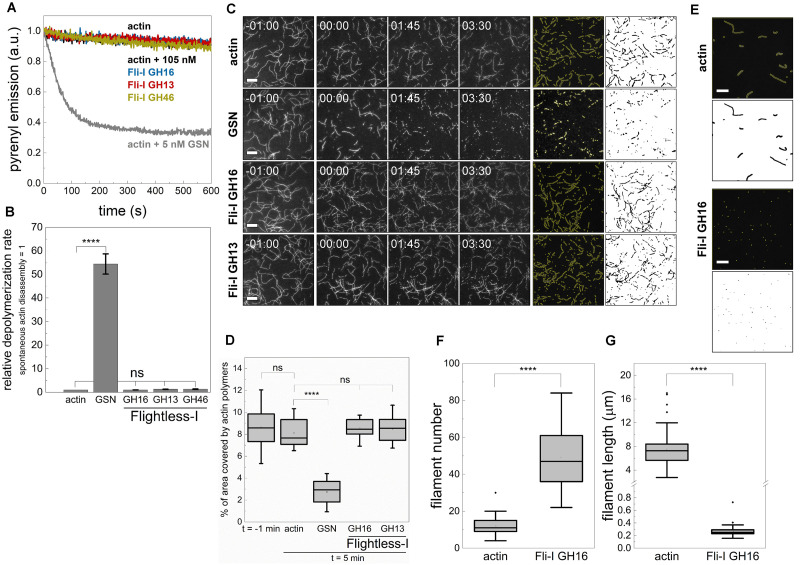
The gelsolin homology domains of Flightless-I do not sever filaments but facilitate the formation of nucleation intermediates. (A) Kinetics of actin polymer disassembly as followed by the decrease in pyrenyl fluorescence emission in the absence or presence of GST-Fli-I or GSN. Conditions: [actin] = 50 nM (50% pyrenyl labeled), [GSN] = 5 nM, [GST-Fli-I] = 105 nM, [CaCl2] = 1 mM. Note that the depolymerization of F-actin in the absence (actin; black line) and presence of different GST-Fli-I constructs (105 nM; blue, red and yellow traces, as indicated) follow similar kinetics; the pyrenyl traces largely overlap. While that of recorded in the presence of GSN (5 nM; gray) differs significantly. (B) Relative depolymerization rate derived from the pyrenyl transients shown on panel (A), n = 2–3. (C) Left panels: Representative montages of actin disassembly followed by TIRFM in the absence or presence of GST-Fli-I or GSN. The frames labeled by -01:00 and 00:00 show the field of view just before and right after the addition of GSN or GST-Fli-I, respectively. Right panels: Representative skeletonized TIRFM images used for filament area analysis showing the field of view of a 66 × 66 μm2 region in the absence or presence of GSN or GST-Fli-I. Conditions: [actin] = 0.5 μM (10% Alexa488NHS labeled), [GSN] = 0.5 nM, [GST-Fli-I] = 105 nM. Scale bar = 10 μm, time = min:s. (D) Percent of the area covered by actin filaments 5 min after the addition of GSN or GST-Fli-I derived from TIRFM images shown on (C), n = 12–51. (E) Representative skeletonized TIRFM images used for filament number and length analysis showing the field of view of a 66 × 66 μm2 region in the absence or presence of Fli-I GST-GH16. Conditions: [actin] = 2 μM (10% Alexa488NHS labeled), [Fli-I GST-GH16] = 800 nM. Scale bar = 10 μm. (F) Number of filaments assembled from G-actin either spontaneously or in the presence of Fli-I GST-GH16 derived from TIRFM images shown on (E), n = 69–73. (G) Filament length assembled from G-actin either spontaneously or in the presence of Fli-I GST-GH16 derived from TIRFM images shown on (E), n = 69–73. ****p < 0.0001.